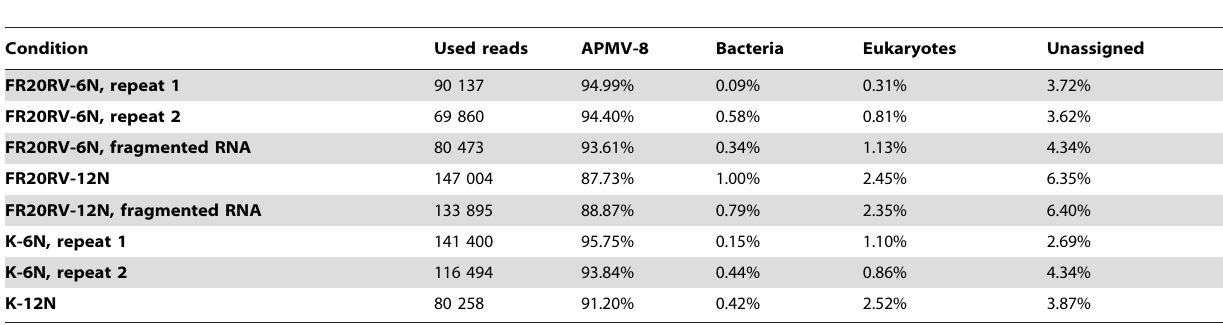
Table 3. Metagenomic analysis of all sequence raw data from the different studied conditions.